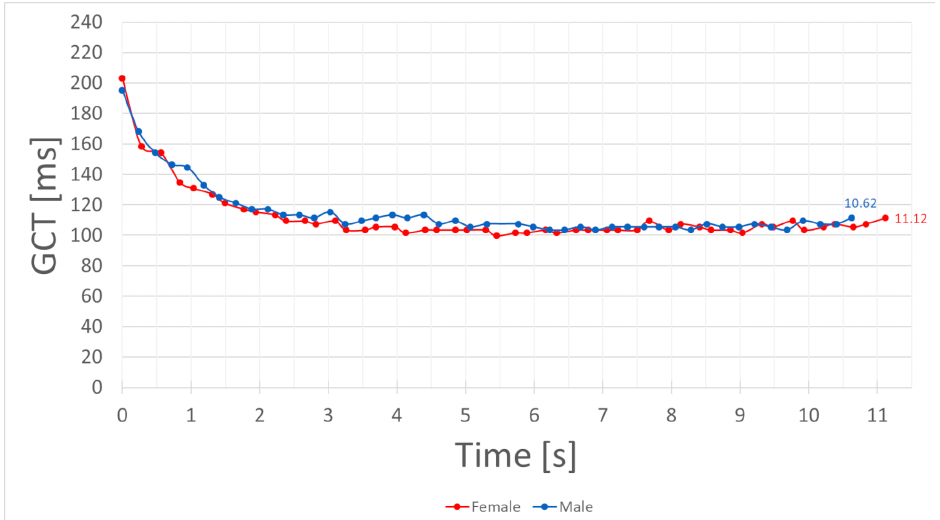
Figure 6. IMU-measured GCT of a female (red) and a male (blue) sprinter over 100 m. The marked dots on each line represent ground contacts. The connecting line between the dots is added for better visual separation. The time of the last contact represents the total period between the first and the last step of the respective